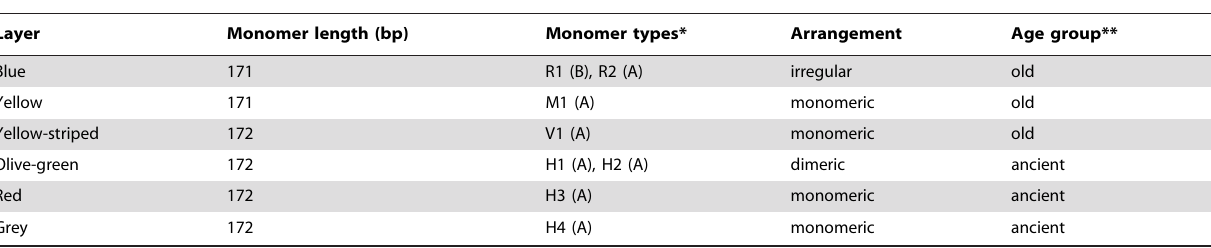
Table 1. Structural features in dead AS